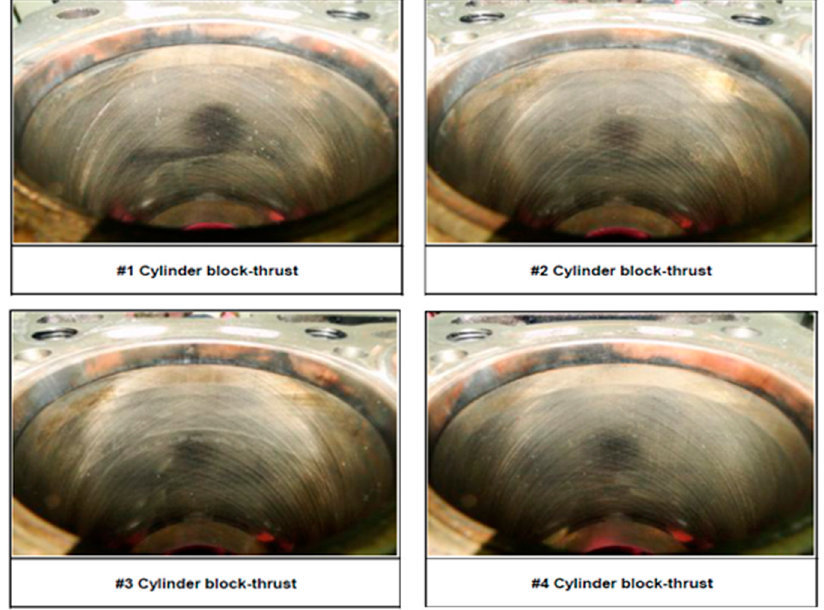
Figure 14. Abrasion of the cylinder block after the durability test. The maximum torques were measured with an engine dynamometer during the durability test, and the fuel consumption was also measured using a flowmeter. The relationship between the torque and output is given by Equation (5). The fuel consumption of the engine can be expressed as a break-specific fuel consumption (BSFC), which is the fuel consumption rate per unit output, and can be calculated by using Equation (6). The changes in the engine torque and BSFC measured during the 300 h durability test are presented in Figures 15 and 16. As the durability test progressed, the engine stabilized as the mechanical aging progressed, while decrements in the torque and BSFC gradually diminished. Specifically, the boost-up by the turbocharger started in full swing, and from 1500 rpm, when the combustion stabilized, the differences between the starting and final values of both the torque and BSFC were within 5%. Therefore, when the modified AC4CH material was used for the cylinder block, the durability of the engine cylinder black could be secured.